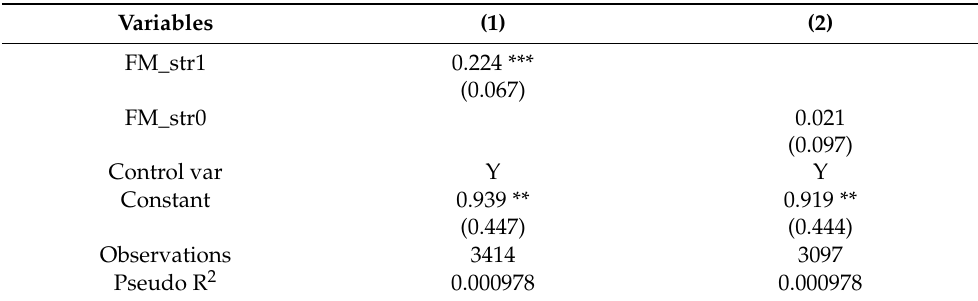
Table 6. Transform Estimation Sample